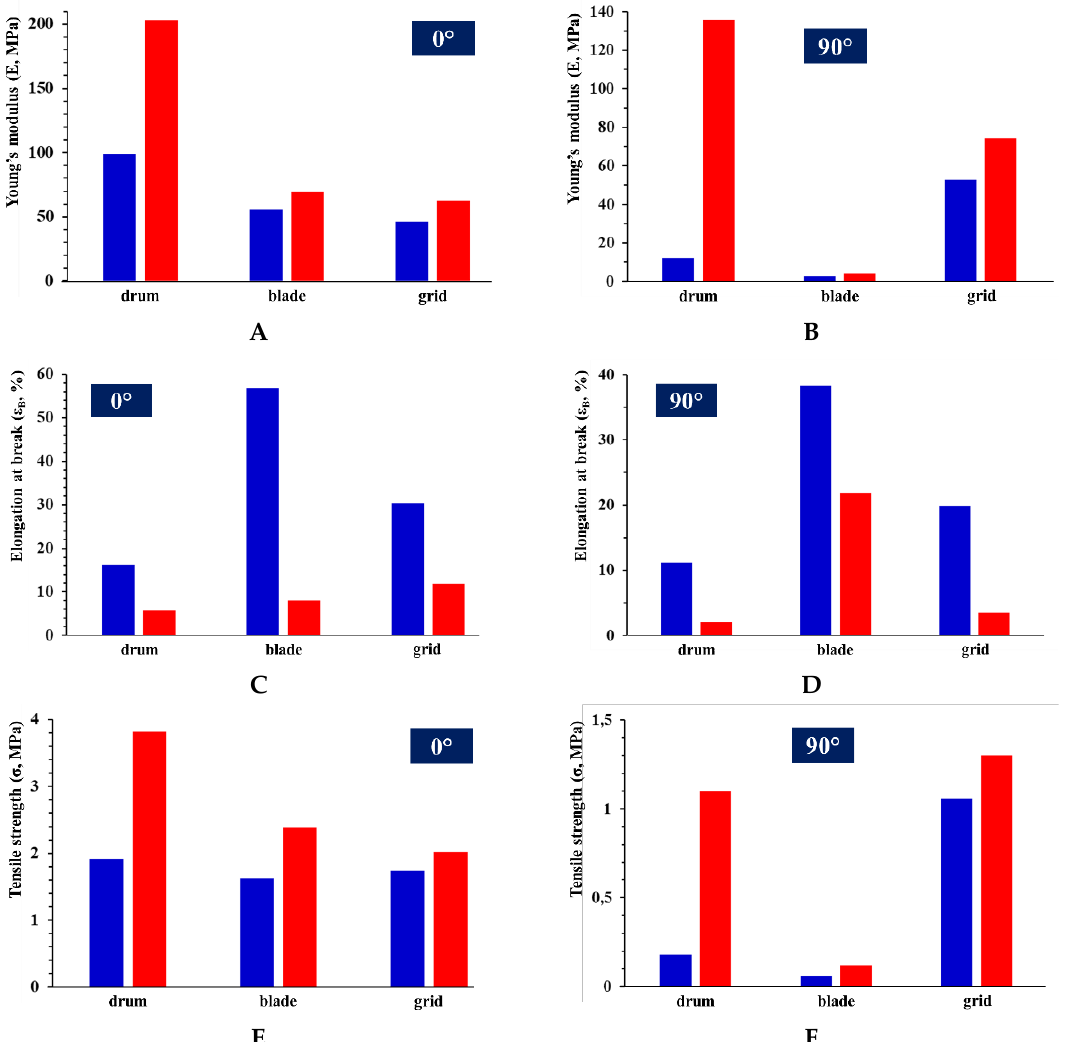
Figure 8. Modulus of elasticity ( A,B ), elongation at break ( C,D ) and tensile strength ( E,F ) of the PHB / PCL mats before (blue) and after (red) thermal treatment onto three types of rotating collectors and at di ff erent directions of cutting (0 ◦ or 90 ◦ ).